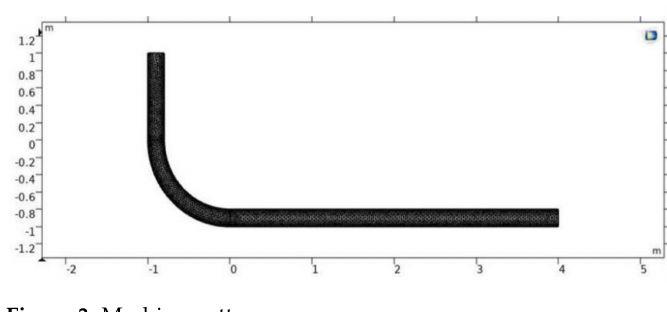
Figure 2. Geometric simulation.